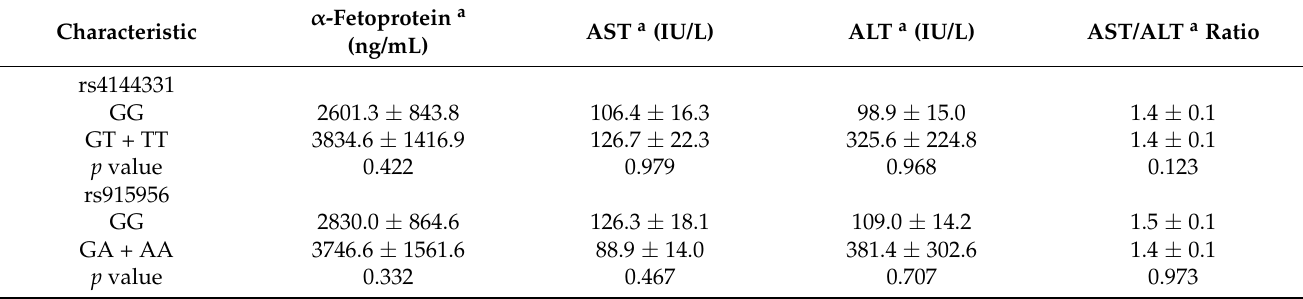
Table 6. Association of TRIM21 genotypic frequencies with the HCC laboratory